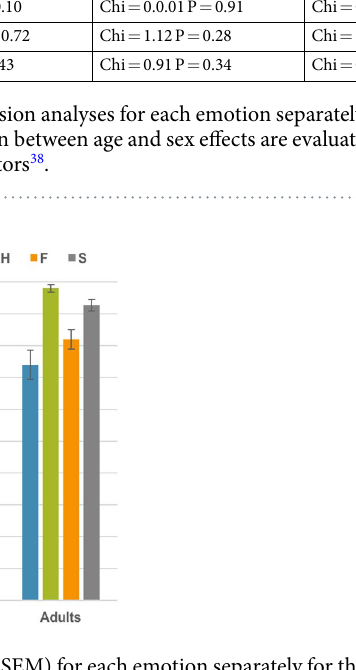
Figure 3. Proportion of correct responses (Mean and SEM) for each emotion separately for the five age groups (Children: 5–8 years old; early adolescents: 9–11 years old; mid-adolescents: 12–14 years old n = 54; late- adolescents: 15–17 years old and